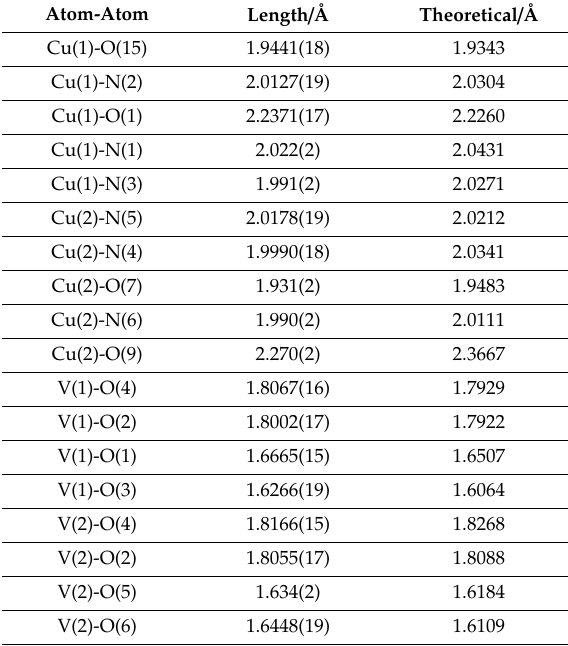
Table 2. Representative distances of Compound 1 .